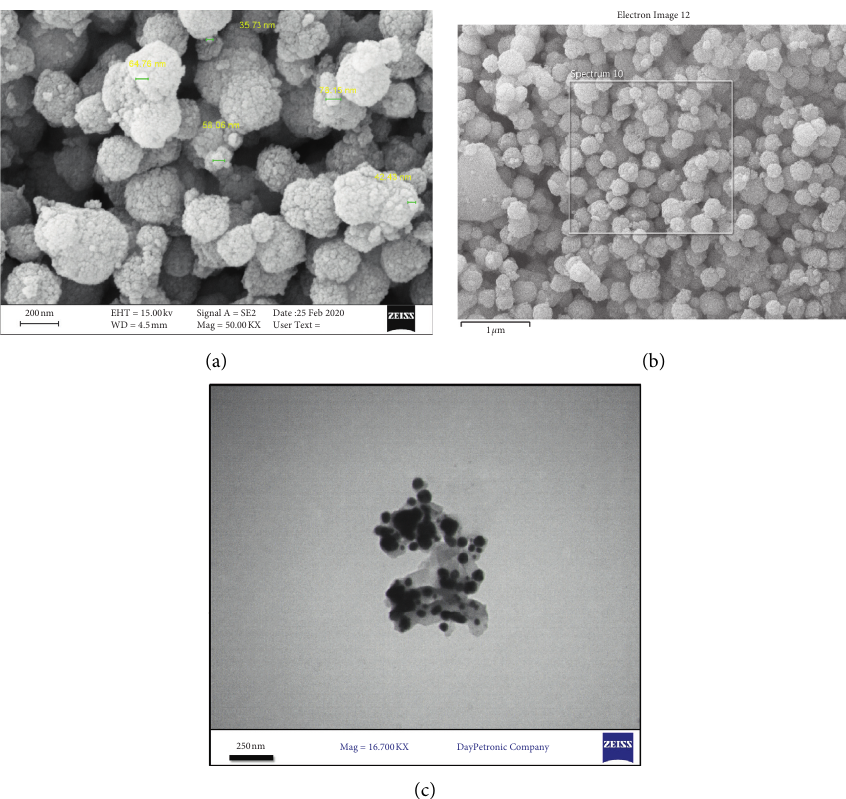
Figure 1: (a, b) SEM images of silver-doxycycline complex. (c) TEM image of silver-doxycycline complex.